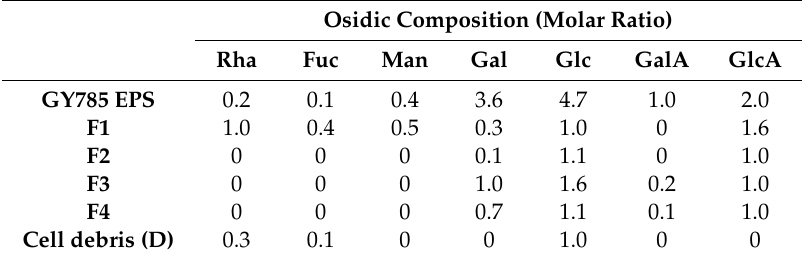
Table 2. Osidic composition (molar ratio) of the native GY785 EPS and the four fractions, recovered after SEC fractionation, and insoluble cell debris (D). Osidic Composition (Molar